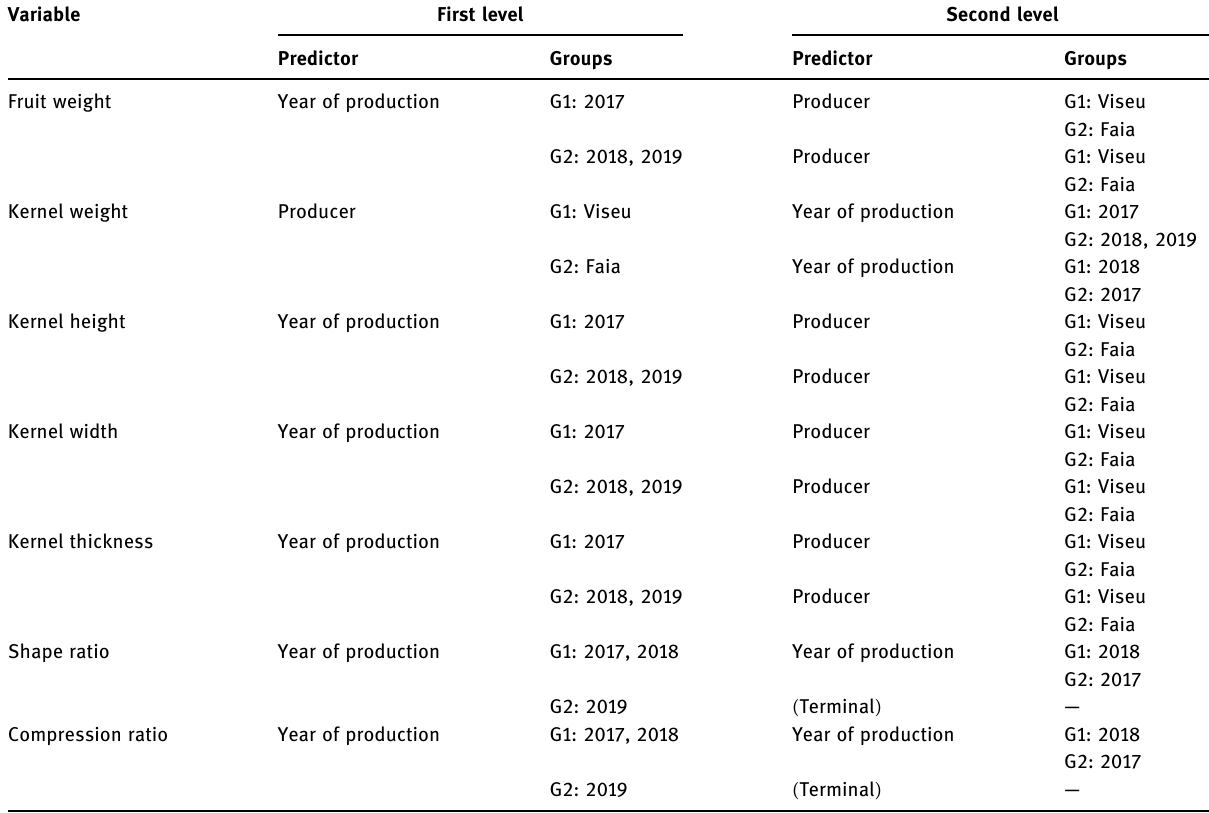
Table 12: Classi fi cation tree for biometric characteristics